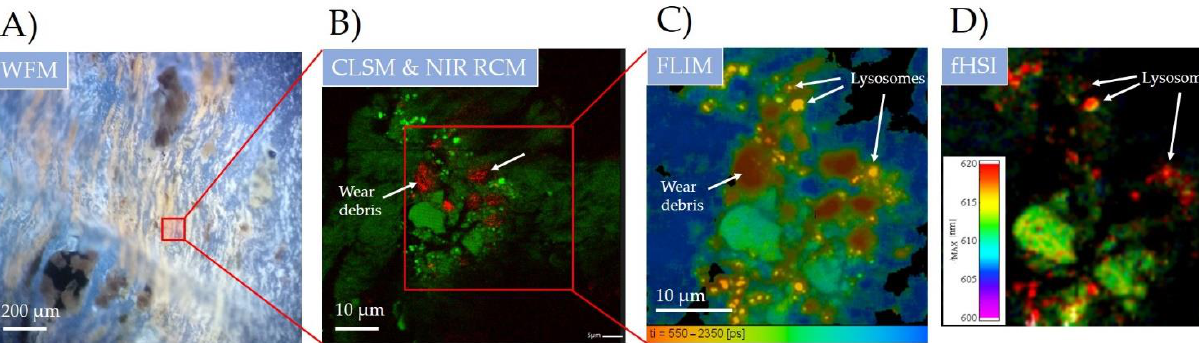
Figure 3. Wear debris identification and its impact on the surrounding biological molecular environment in the periprosthetic tissue on submicron scale using multimodal spectroscopy-based optical imaging. ( A ) widefield fluorescence microscopy (WFM) using LED source (λ = 400 nm); ( B ) hybrid LSCM and NIR CRM (λ = 561 nm and λ = 780 nm); ( C ) fluorescence lifetime (FLIM) and ( D ) hyperspectral fluorescence imaging (fHSI) using 16-channel PMT detector and fast TCSPC electronics (both λ = 561 nm). For more detailed FLIM and fHSI analysis see Figures S4 and S5 in the Supplementary Materials.